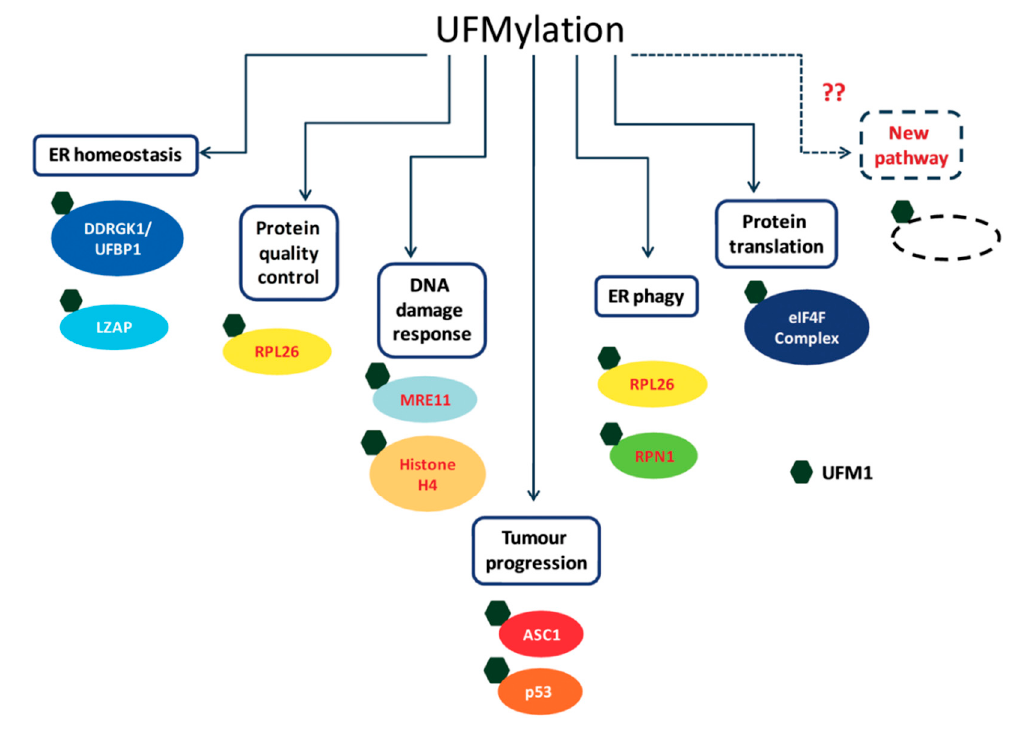
Figure 3. Cellular targets of UFMylation and their cellular Figure 3 . Cellular targets of UFMylation and their cellular roles.